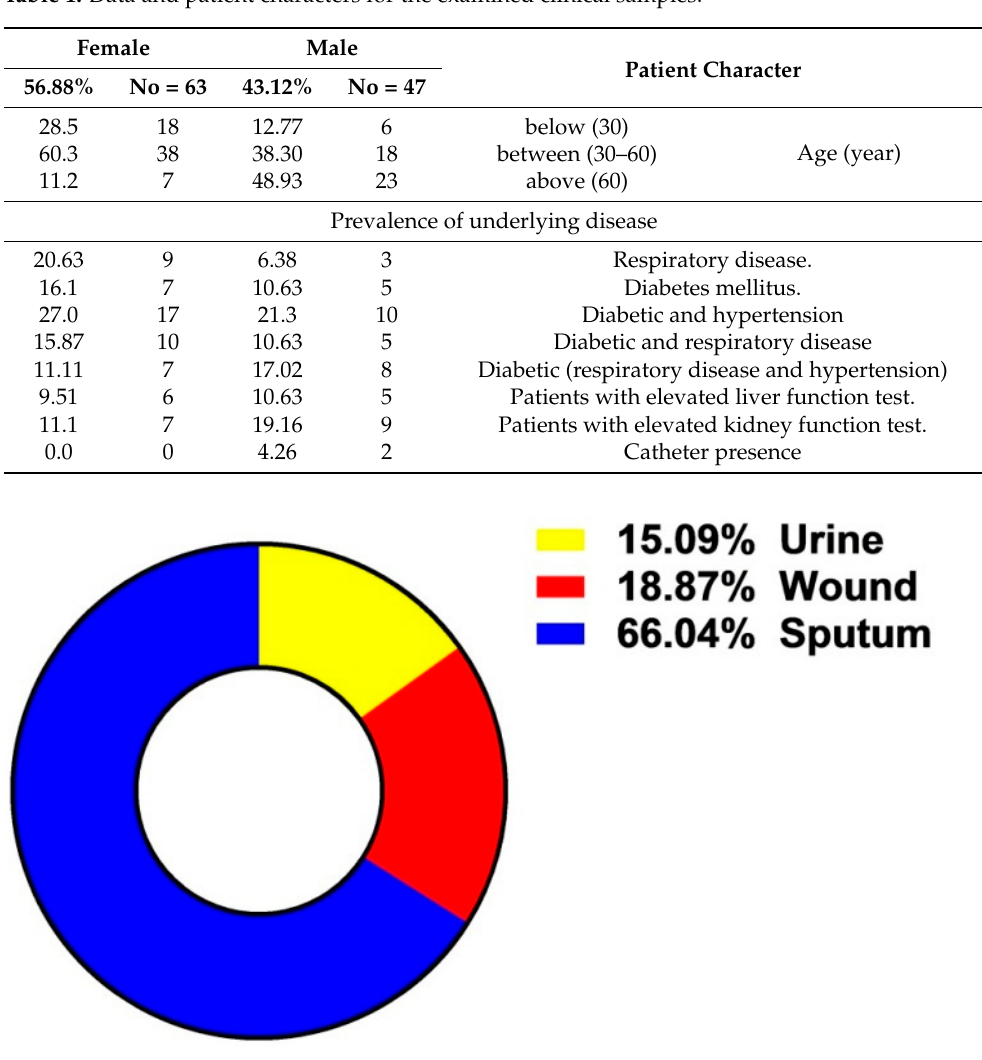
Figure 1. The incidence of Acinetobacter baumannii isolates among examined clinical